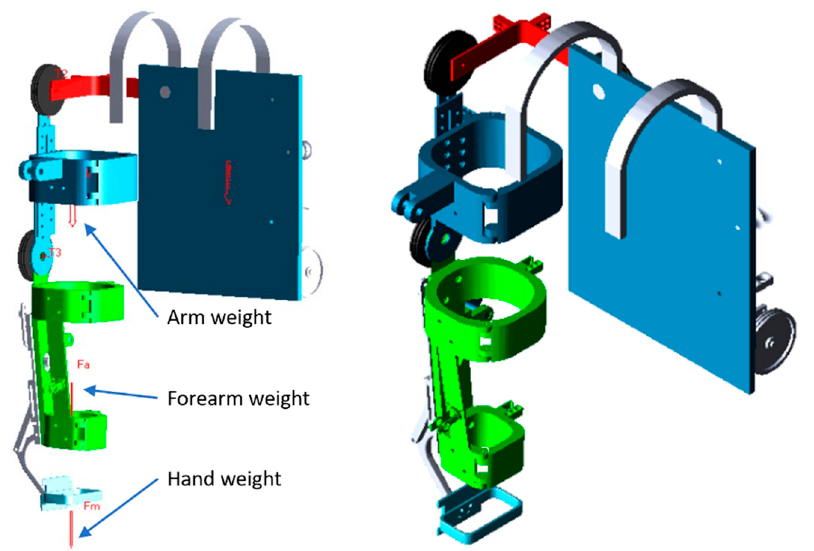
Figure 6. CAD view showing the architecture of the 3-DOF upper limb rehabilitation exoskeleton considering segment weights.